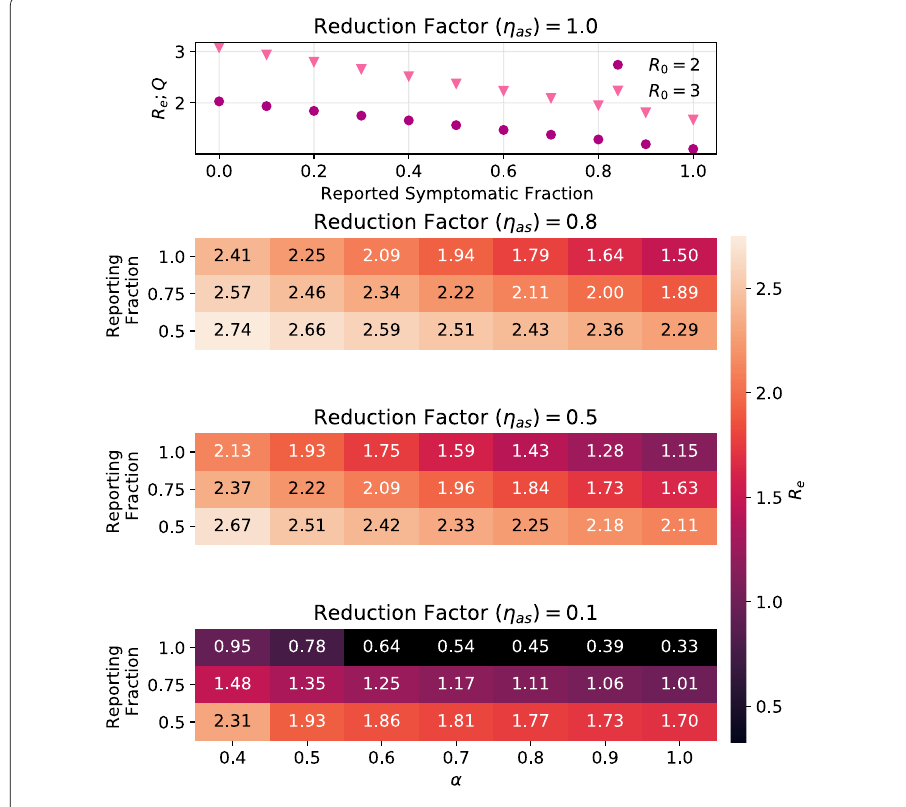
Figure 3 The effective reproductive number reached just from quarantining reported symptomatic carriers, R e ; Q , is shown for four different values of η as (asymptomatic infectivity scaling) as calculated from Eq. (9). Top panel: In the case of η as = 1, R e ; Q depends only on the product of α (symptomatic fraction) and f m (fraction reported and tested) and is shown for two values of R 0 . Lower three panels: For each combination of η as and α , the infection probability was adjusted to obtain R 0 = 3